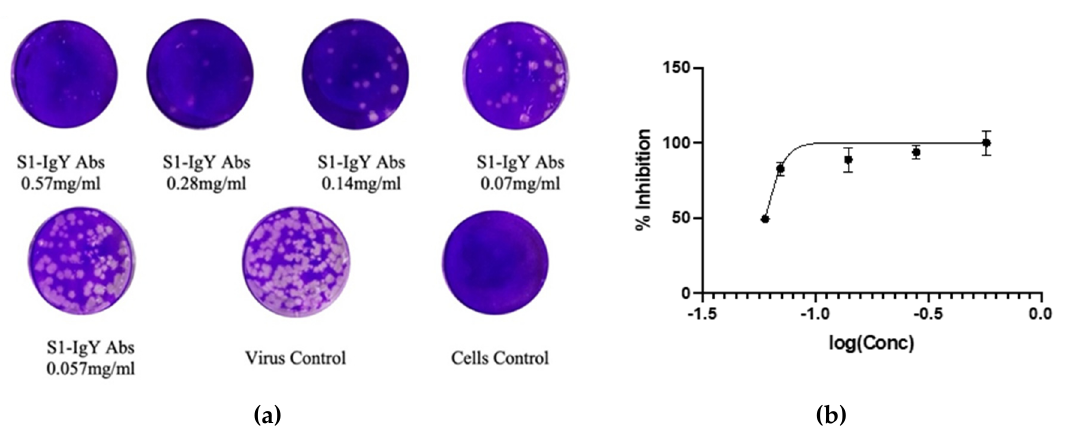
Figure 7. Evaluation of the neutralizing potential of anti-S1 IgY antibodies, using plaque reduction neutralization test. ( A ) MERS-CoV (MOI 0.01) was incubated with different concentrations of anti-S1 IgY antibodies and added to Vero E6 cells. After virus adsorption, agar medium was added to the Vero E6 cells, and the plaques that formed were stained with crystal violet, each IgY concentration was tested in triplicate. ( B ) Percent inhibition of anti-S1 IgY antibodies with different concentrations. The best fit equation is: